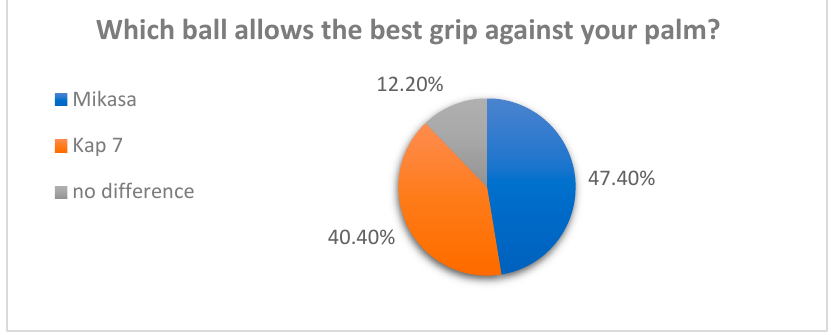
40.40%12.20% 47.40% Figure 1. Grip assessment—survey results. Figure 1. Grip assessment—survey results. When asked which ball was thrown be tt er, 45.6% of respondents chose Kap 7, 40.4% When asked which ball was thrown better, 45.6% of respondents chose Kap 7, 40.4% Mikasa, while the rest did not feel the di ff erence (Figure 2). Mikasa, while the rest did not feel the difference (Figure